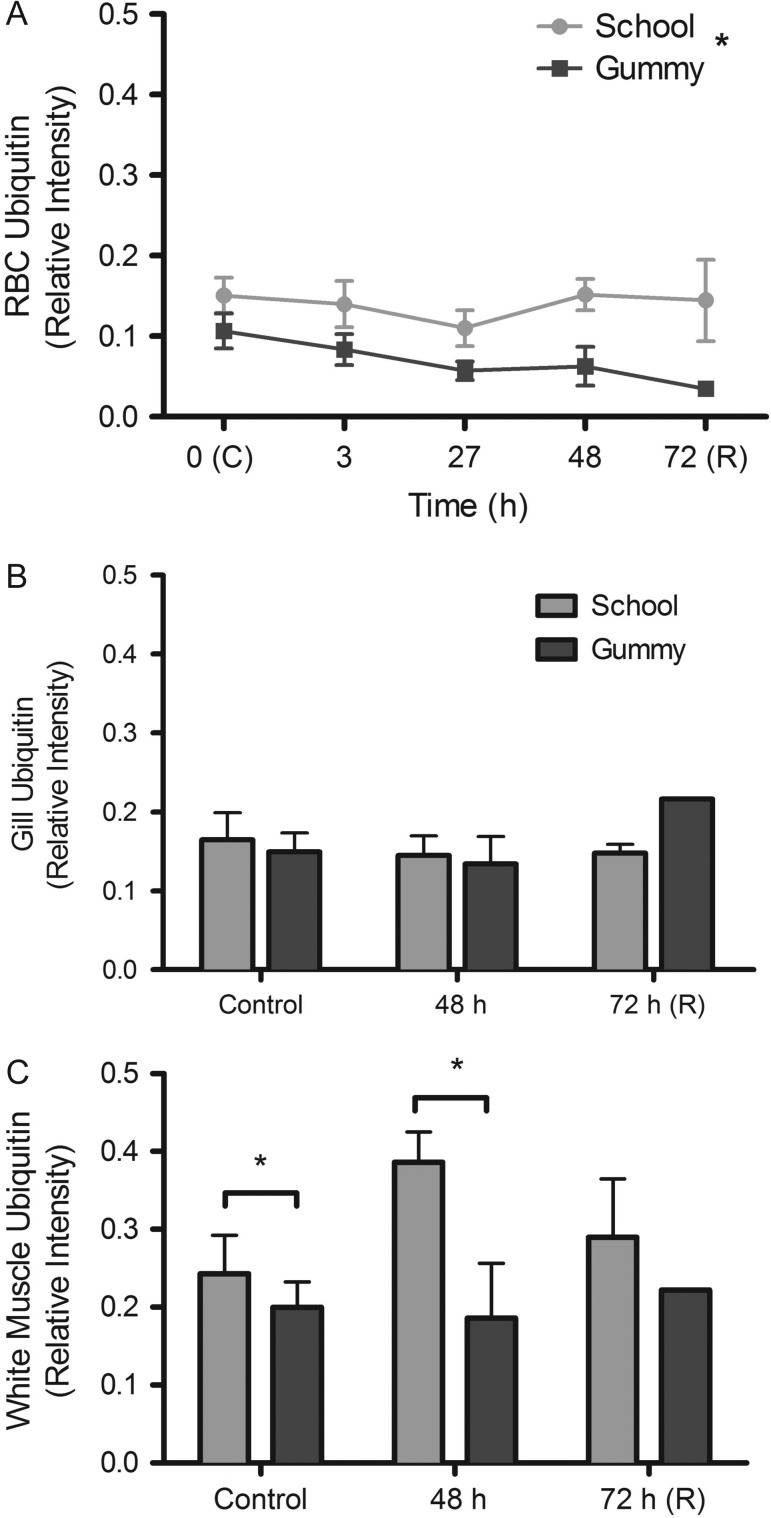
Relative ubiquitin levels (mean values ± SEM) in school
shark (G. galeus) and gummy shark (M.
antarcticus) red blood cells (RBCs; A), gill
(B) and white muscle (C) following exposure to
75% seawater. Asterisk indicates significant effect of species
(P < 0.05; see Materials and
methods for species replication numbers). Recovery (R) data are not included
in the statistical analyses.